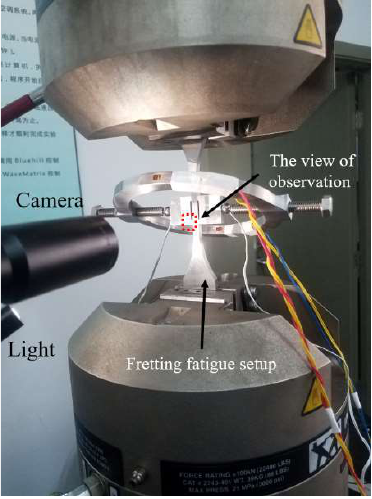
Figure 3. Photograph of the complete experimental setup in this study (The magnified area of the red wireframe is the field of view observed by the camera).